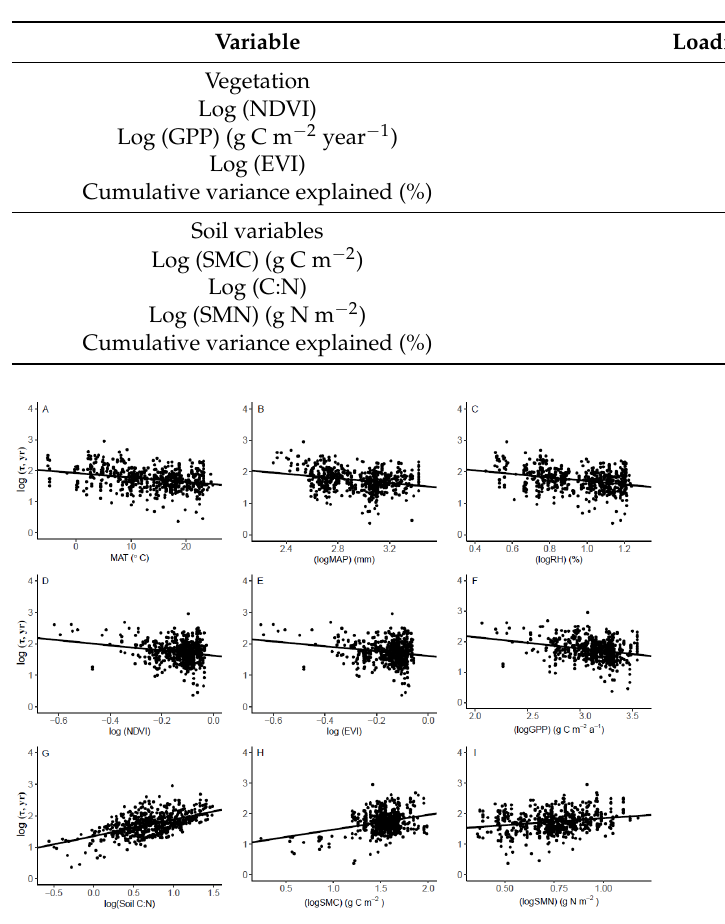
Figure A1. The variation of C turnover time ( τ , naturally log-transformed) according to climatic, soil, and vegetation variables, etc., in the sample mean (A–I) are constant. The fitted lines were deter-mined by GLMM, with sites as the random factor. The parameters are shown in Table A2.